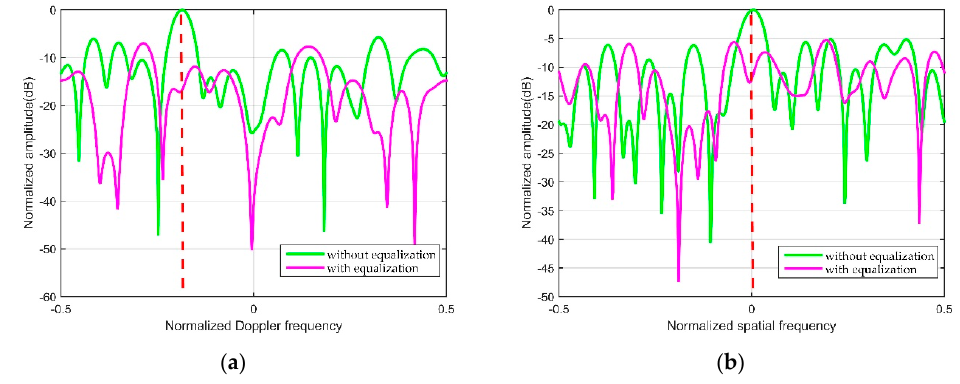
Figure 7. Doppler and spatial dimension of false target: ( a ) Normalized Doppler dimension; ( b ) normalized spatial dimension.